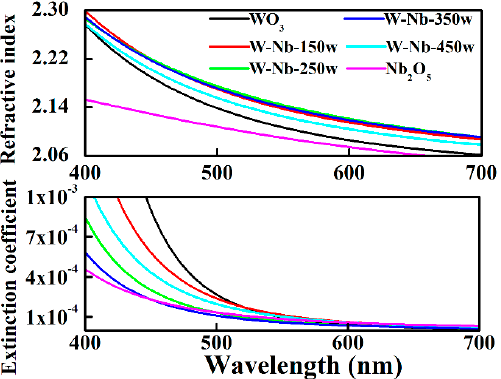
Figure 6. Refractive index and extinction coefficient versus wavelength for WO 3 , WO 3 –Nb 2 O 5 , and Nb 2 O 5 films.